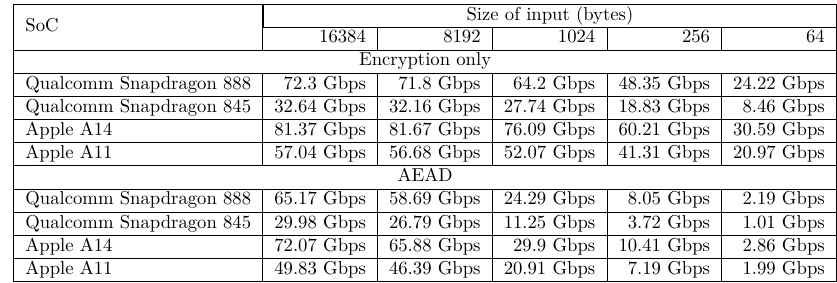
Table 10: Performance on Smartphones